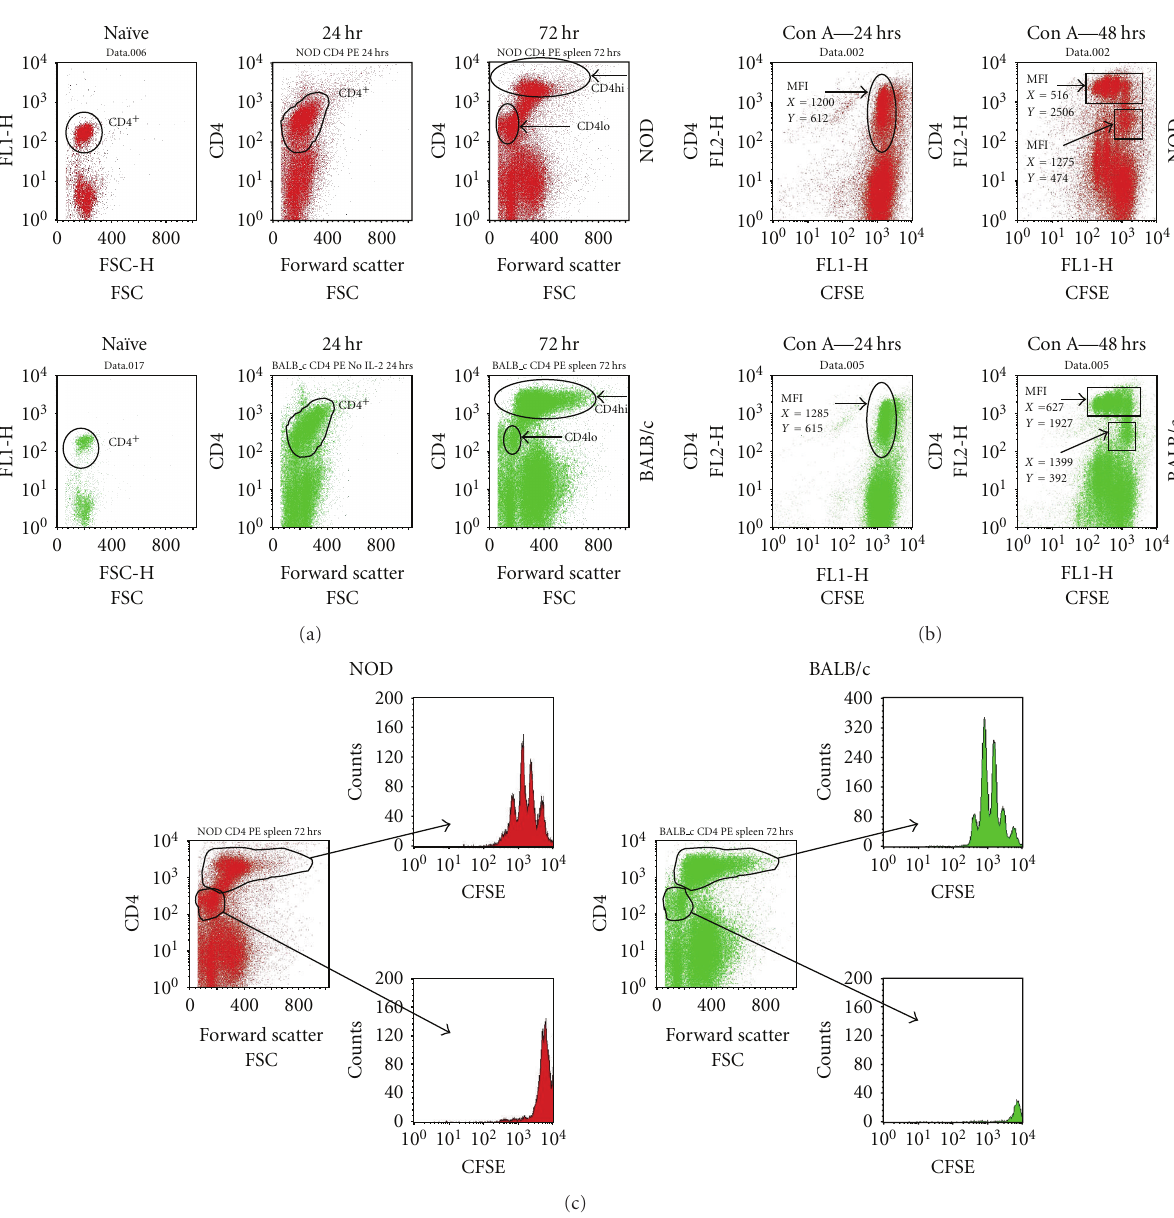
Figure 4: CD4 expression and T cell size increase in T cells undergoing cell division. CFSE-loaded NOD or BALB/c spleen cells were stimulated with Con A, harvested at 24 or 72 hrs, and then counterstained with anti-CD4-PE and CD3-PE/Cy5. For FACS analysis, 100,000 events were collected. The plot represents gated CD3+ cells. (a) Temporal analysis of CD4 expression and size (FSC) among Con A blasts. (b) CD4 expression and cell division (CFSE) in Con A blasts. The mean fluorescence intensity (MFI) for CFSE ( X ) and CD4 ( Y )